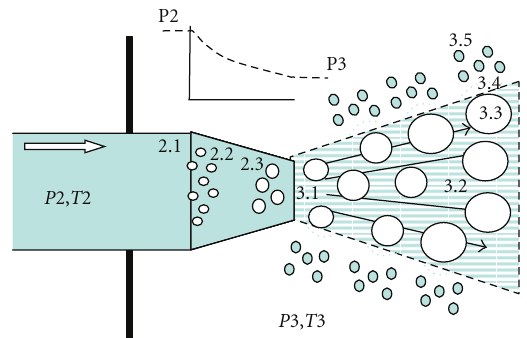
Figure 8: Illustration of the physical process of e ff ervescent atomization by boiling.